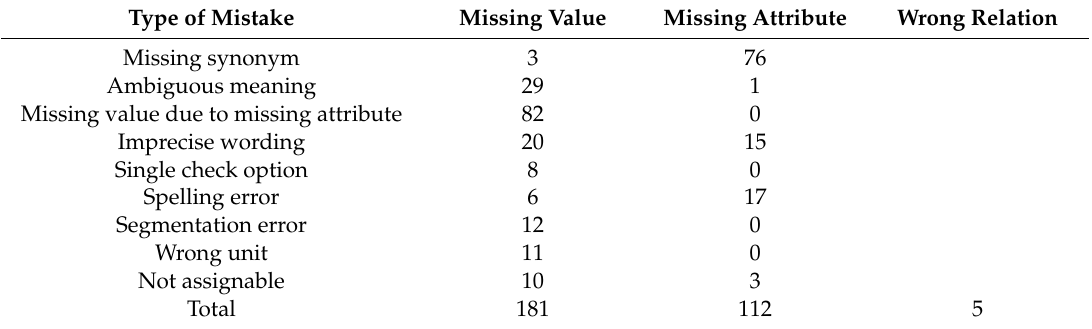
Table 4. Results of the detailed error